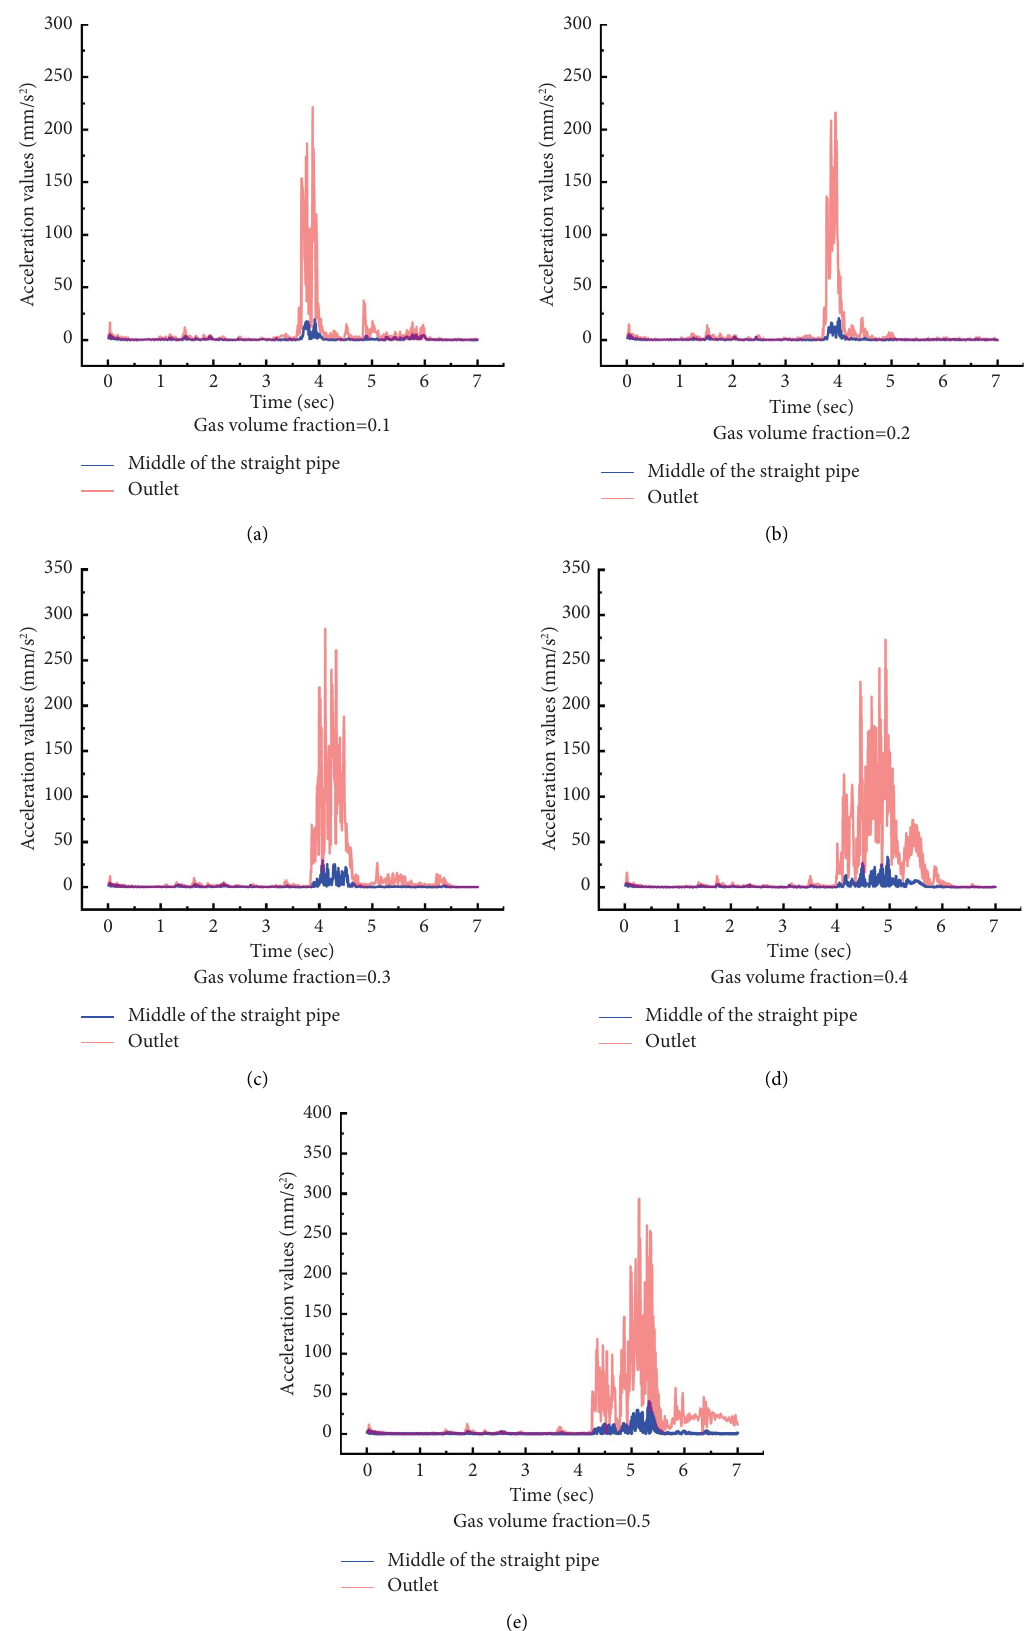
Figure 15: Te time-domain diagram of the vibration response of monitoring points at diferent gas volume fractions. (a) Volume fraction � 0.1. (b) Volume fraction � 0.2. (c) Volume fraction � 0.3. (d) Volume fraction � 0.4. (e) Volume fraction �